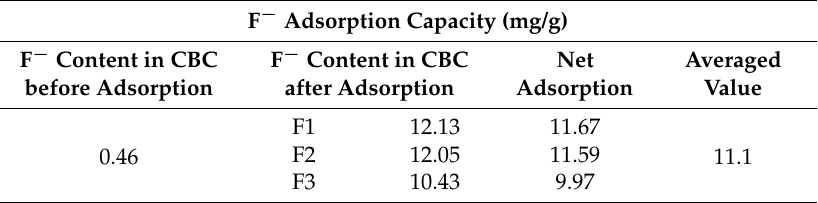
Table 2. Averaged value of adsorption capacities of F1, F2, and F3.